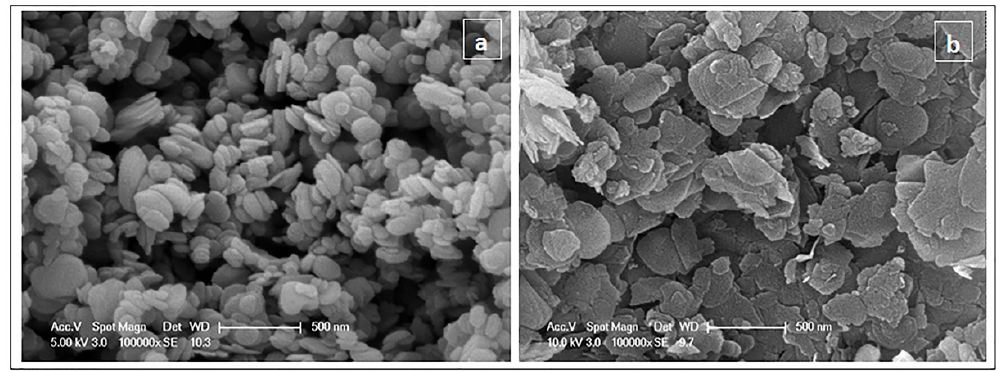
Figure 1. Scanning Electron Microscopy (SEM) micrograph of particles after 60 min ultrasonication ( a ) silanized BN ( b ) silanized FBN.